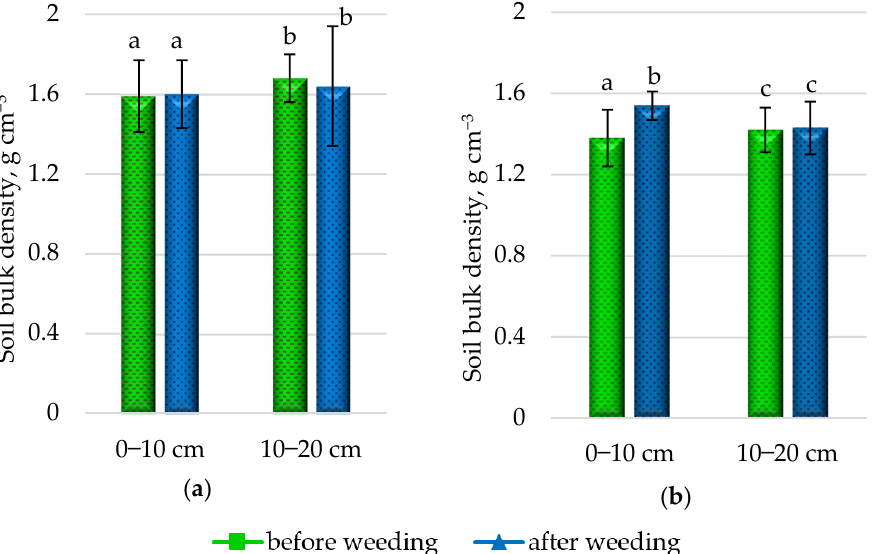
Figure 5. Soil bulk density before and after the weed control process at depths of 0–10 and 10–20 cm: ( a ) CWC2 (4 June 2021); ( b ) RWC (1 July 2021). Different letters a, b, and c in the figures indicate statistically significant differences.